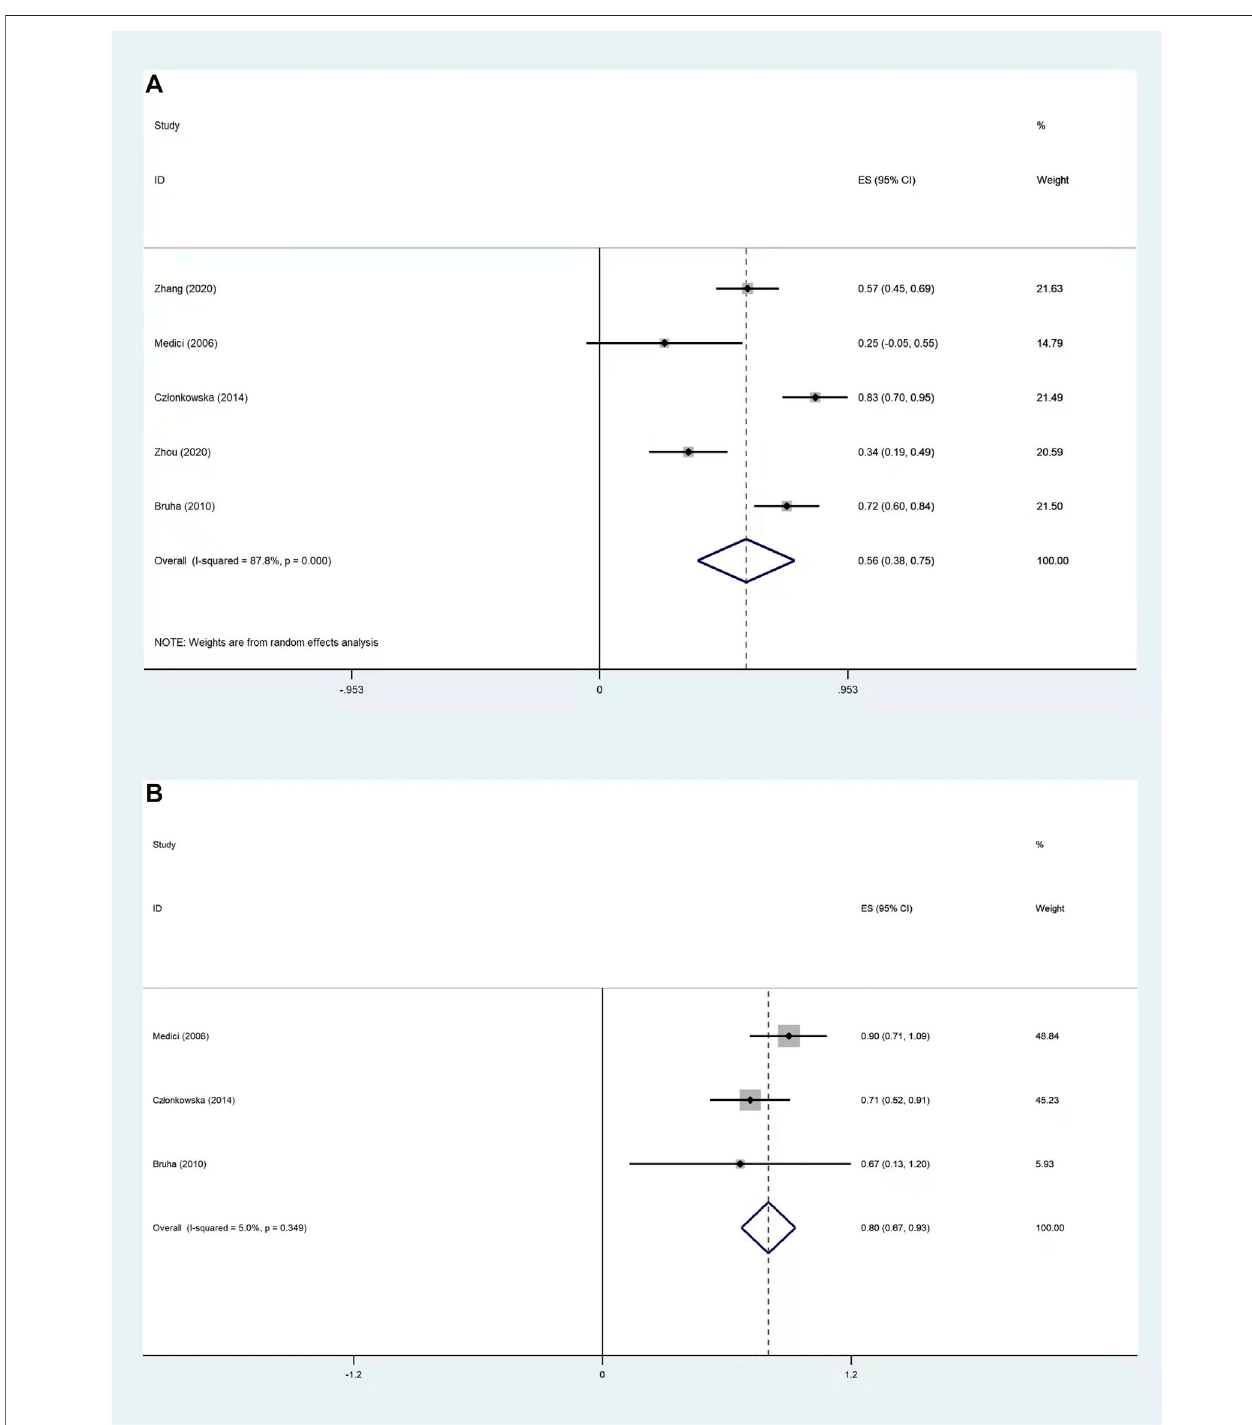
FIGURE 3 | Forest plot of the pooled improved rate for neurological WD patients treated with D -penicillamine (A) and zinc salts (B) .